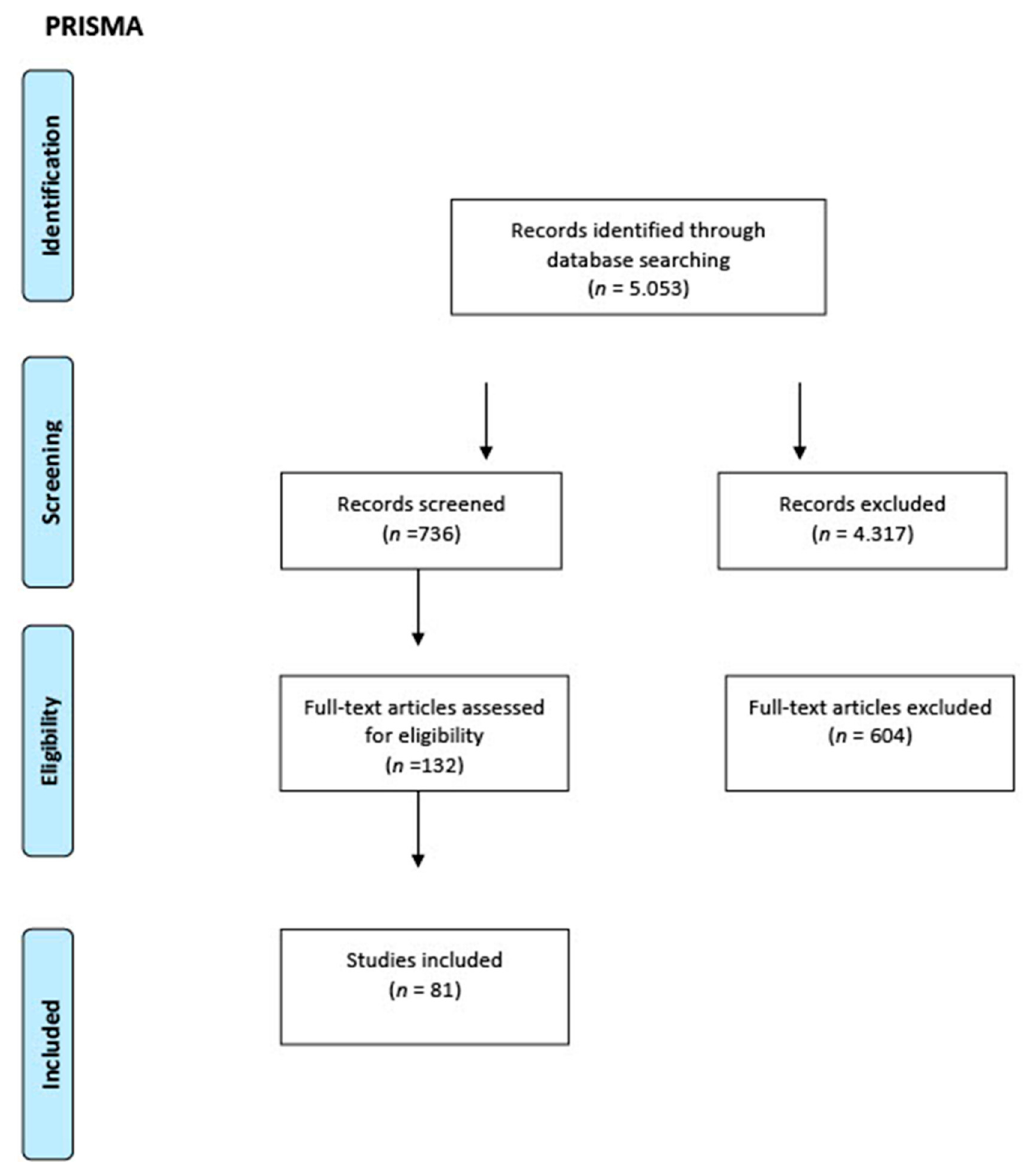
Figure 1. PRISMA workflow.